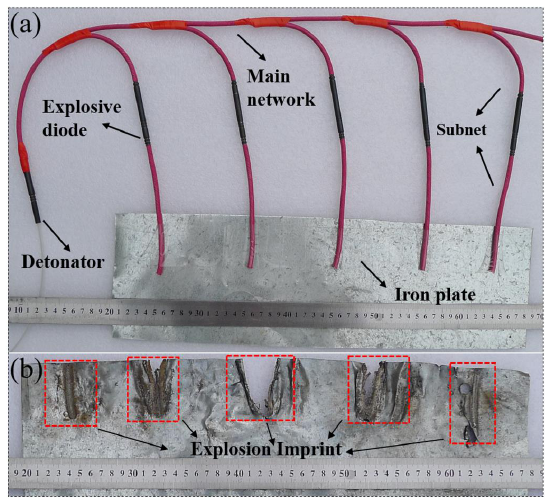
Figure 10. Network of the detonation propagation experiment ( a ) and results ( b ).